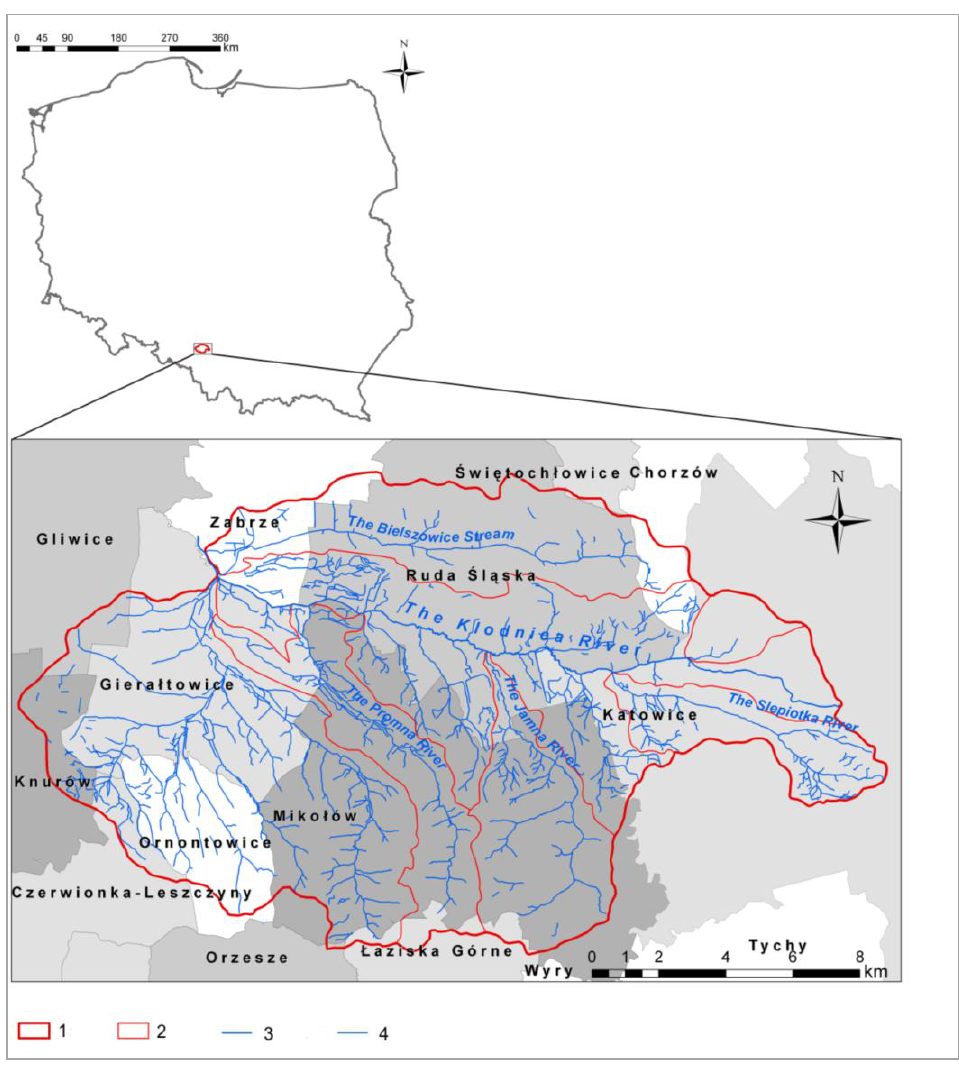
Fig. 1. Location of the upper part of the Kłodnica catchment